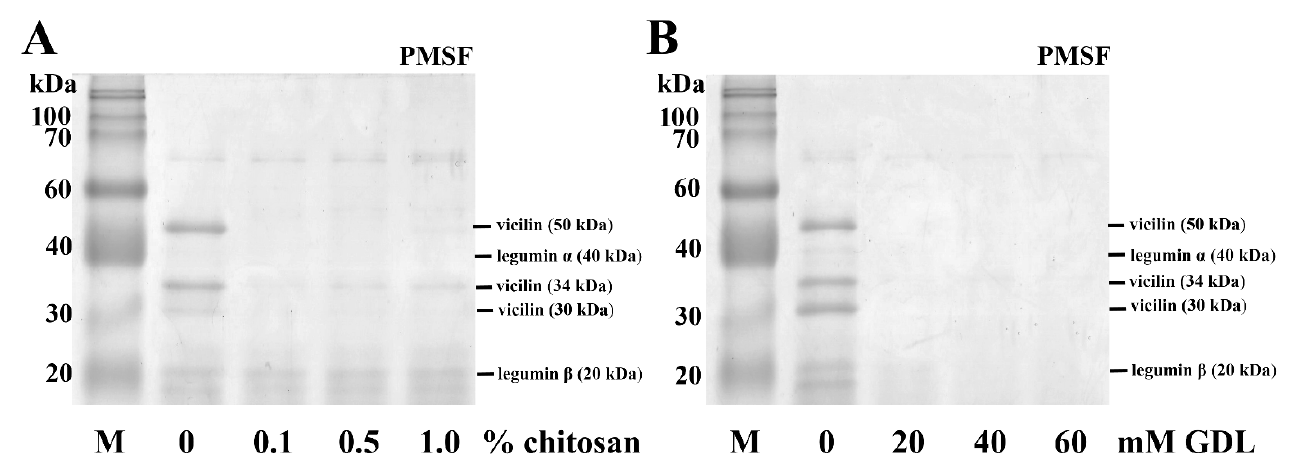
Figure 5. SDS-PAGE profiles of pea milk supernatant fraction (PMSF) following incubation at 85 °C for 15 min: ( A ) with chitosan (0, 0.1, 0.5 and 1.0%), and ( B ) with GDL (0, 20, 40, and 60 mM). M, protein markers.